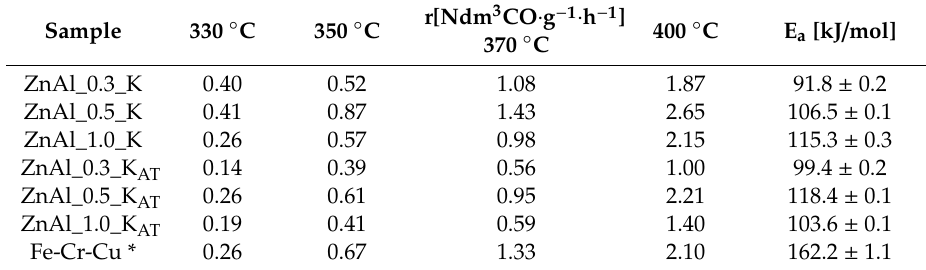
Table 2. HT-WGS reaction rates with ZnAl_X_K and ZnAl_X_K AT catalysts with di ff erent Zn / Al molar